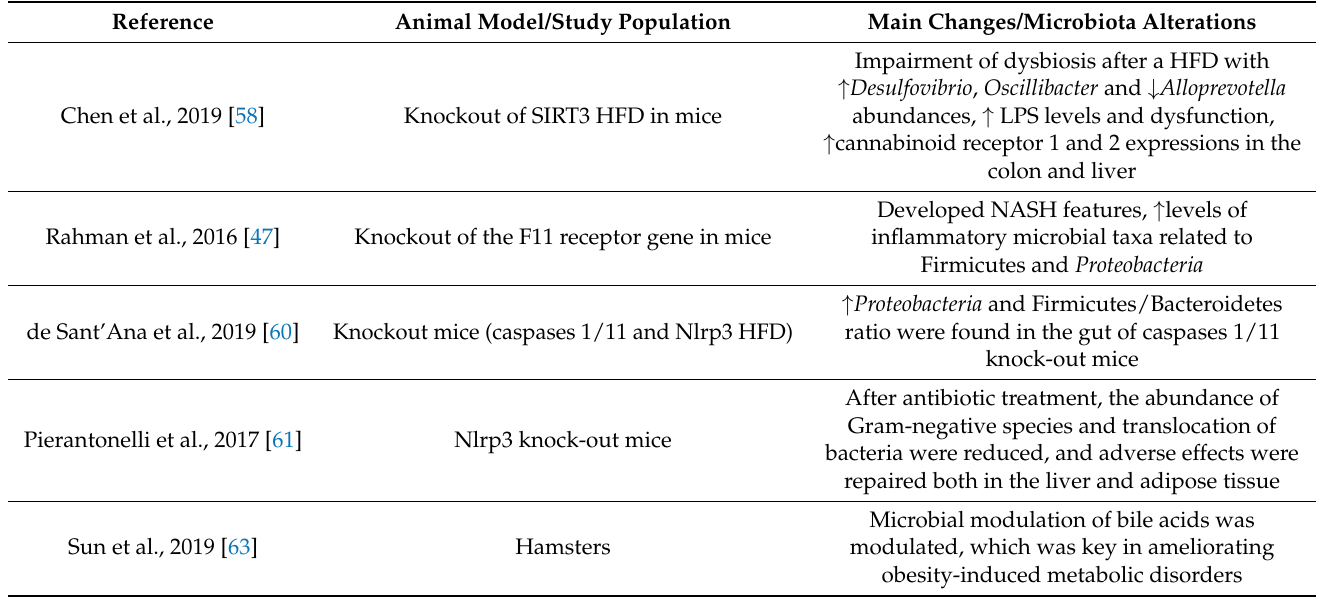
Table 1. Main information from gut microbiota and non-alcoholic steatohepatitis